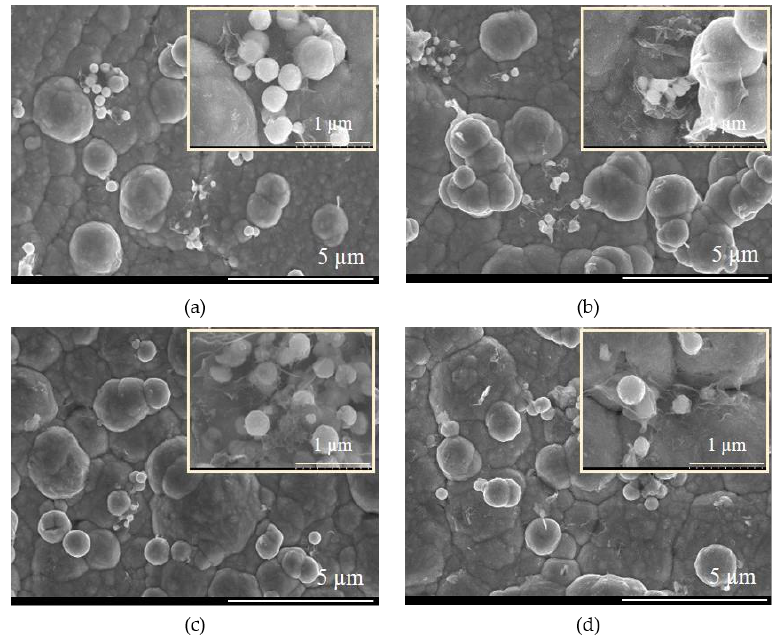
Figure 5. SEM micrographs of NiSn-rGO obtained at di ff erent peak current densities: ( a ) NiSn-rGO-P3.1, ( b ) NiSn-rGO-P3.2, ( c ) NiSn-rGO-P3.3 and ( d ) NiSn-rGO-P3.4.